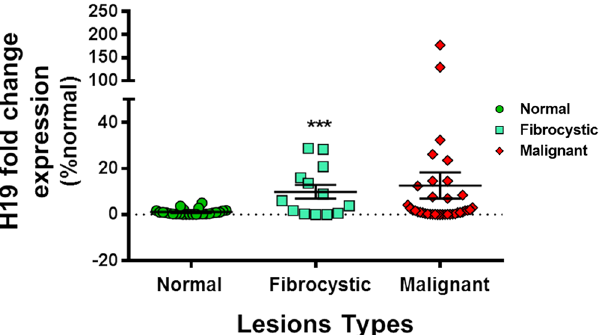
Figure 3. H19 levels are high in fibrocystic lesions. Fibrocystic lesions presented an H19 fold change expression level of 9.9 (9.9 ± 2.9) while malignant lesions had an H19 expression level of 12.34 (12.3 ± 5.5). Expression levels were normalized to GAPDH expression. Results were expressed as means ± SEM. ANOVA and t-test, ***p <